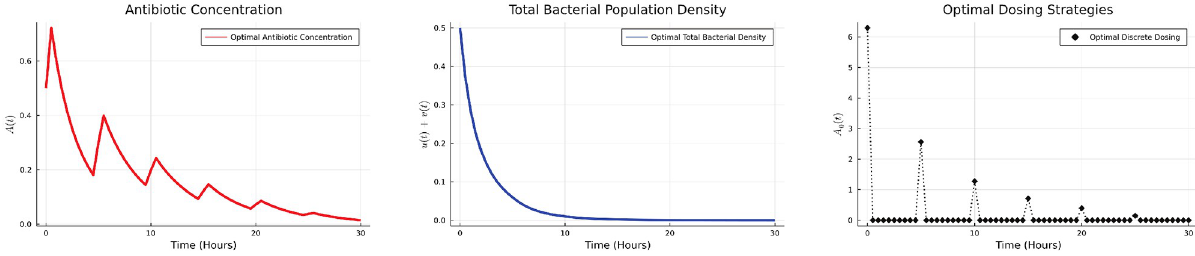
Fig 4. Optimal dosing strategy and